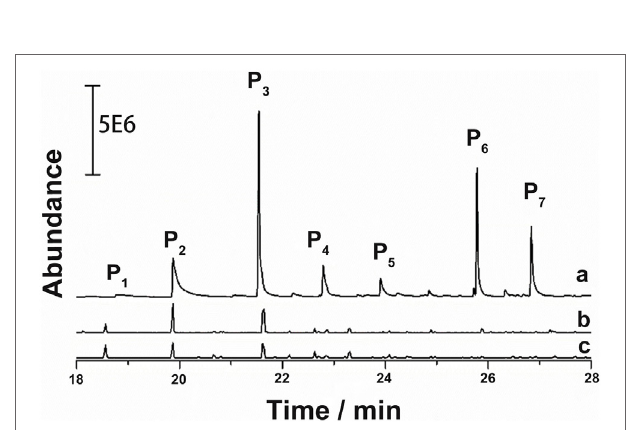
FIGURe 8 | GC–MS spectrum of the products from lignin depolymerization on Pd-zeolite (a) and commercial Pd/Al 2 O 3 –zeolite composites catalysts [(b) 40 mg of Pd/Al 2 O 3 + 200 mg of zeolite and (c) 4 mg of Pd/Al 2 O 3 + 200 mg of zeolite] at 200°C.